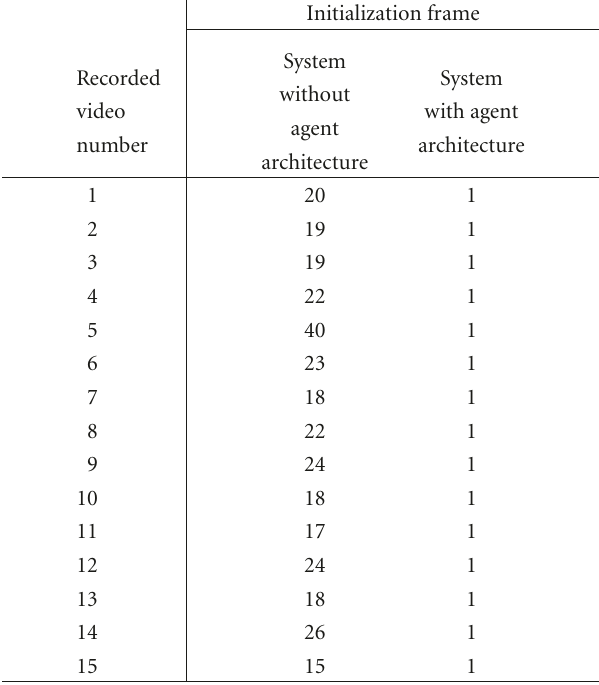
Table 1: Comparison of the initialization of an intruder track for the two available systems. The system with agent architecture initial- izes the track when a message from the outside camera is received by the inside camera (frame number